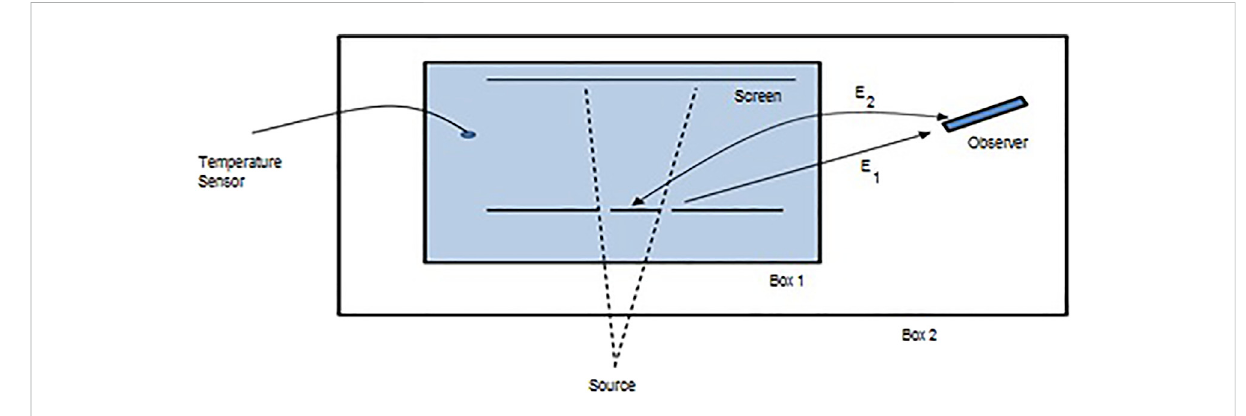
FIGURE 1 Schematics of the setup for experiment